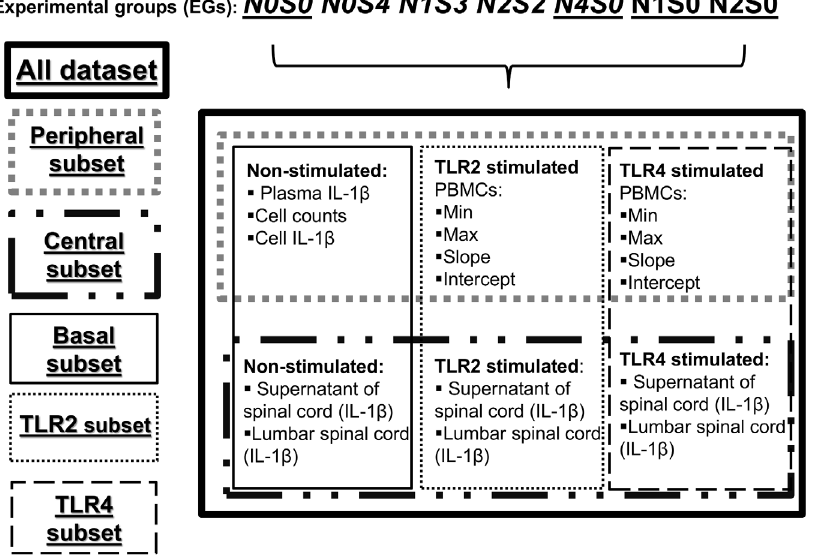
Figure 2. The schematic representation of the breakdown of data according to anatomical location and stimulations. Experimental groups N0S0 and N0S4 are present in both ‘‘neuronal and subcutaneous’’ (italics) and in ‘‘neuronal’’ (underline).